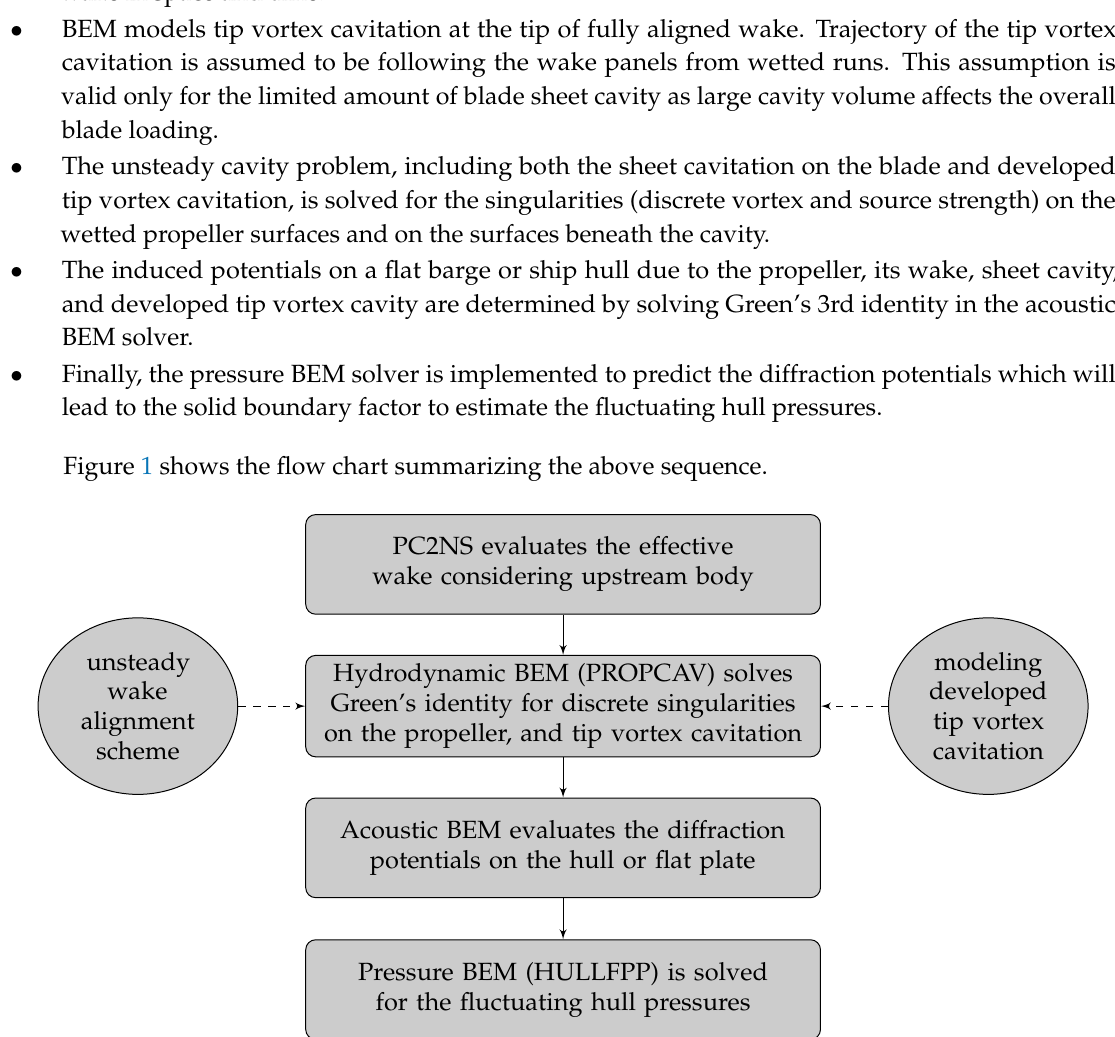
Figure 1. Flowchart of the numerical methods applied in a series to solve the unsteady hull pressure